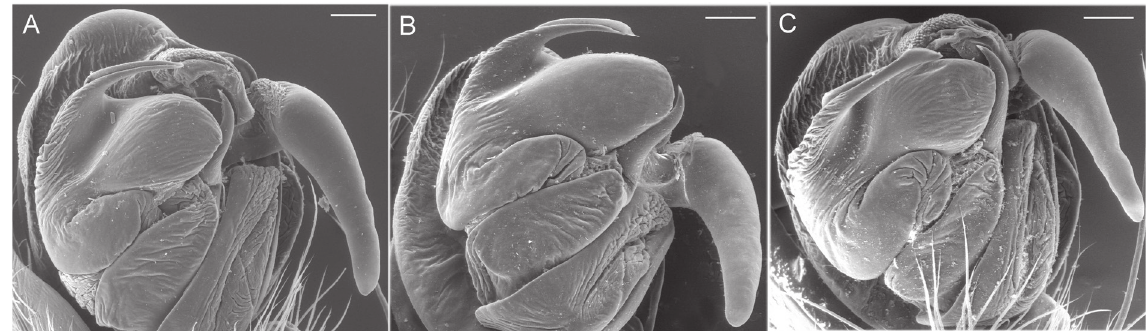
Fig. 5. Electron microscopic photographs of ♂ left palp. A . Eustala occidentalis sp. nov. B . Eustala meridionalis sp. nov. C . Eustala orientalis sp. nov. Scale lines = 0.1 mm.